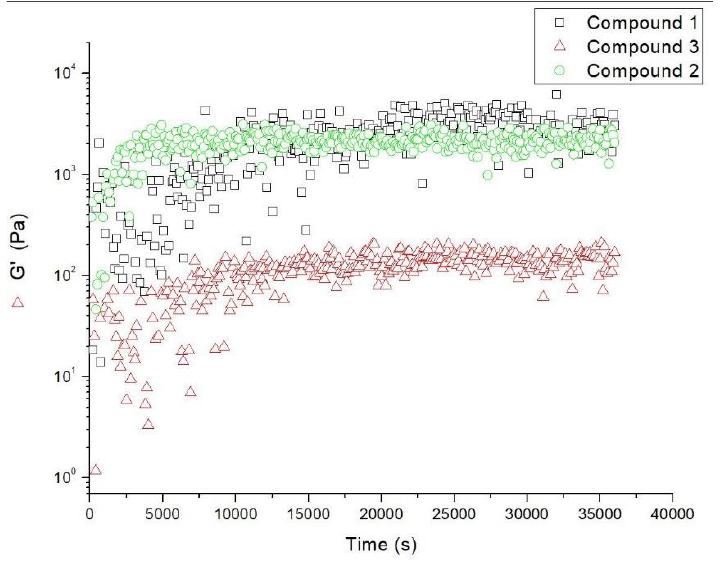
Figure 5. Elastic modulus during the kinetic process of gelation for dehydrodipeptides 1–3 at 0.2 wt%.